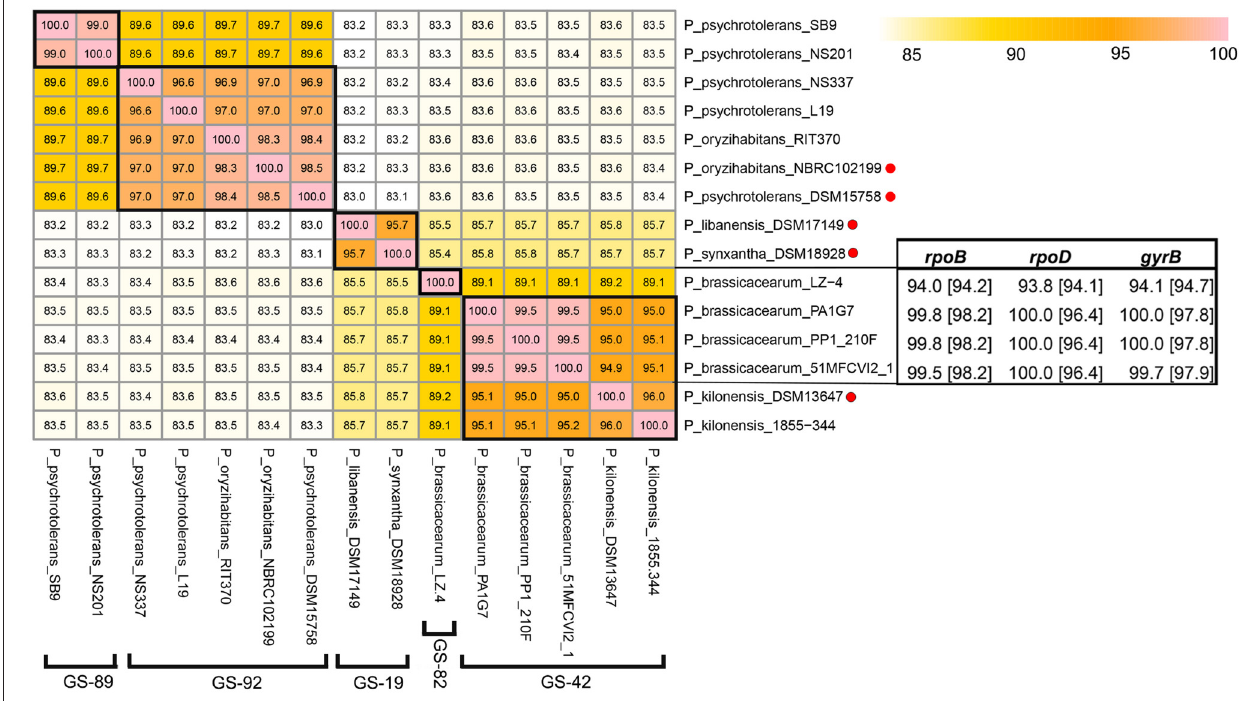
Frontiers in Microbiology |